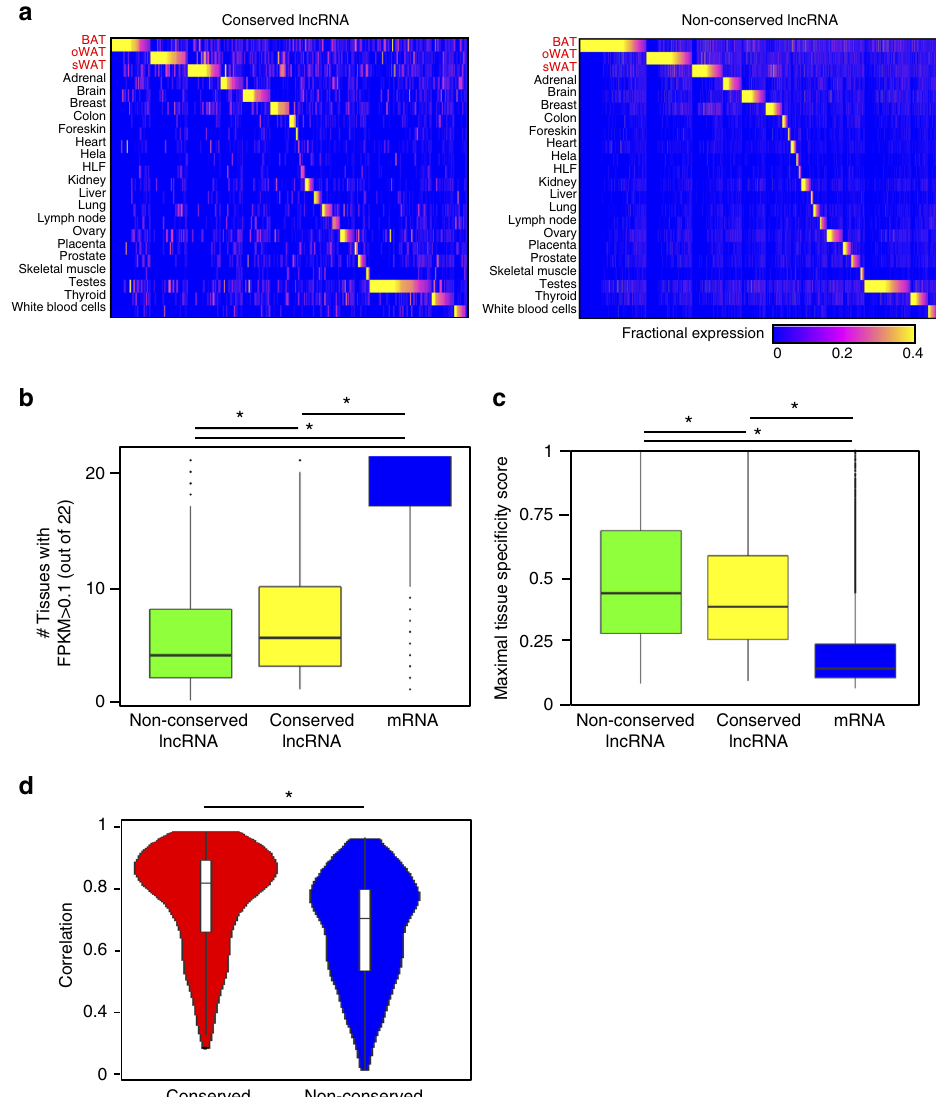
Fig. 5 Conserved lncRNAs are more broadly expression in more tissues types. a Tissue speci fi city of 318 conserved (left panel) and 2831 non-conserved (right panel) lncRNAs across 22 examined human tissues. b Boxplots comparing the counts of tissues in which non-conserved lncRNAs, conserved lncRNAs, and mRNAs can be detected (FPKM > 0.1). Tissue counts refer to the number of tissues (out of 22) that show expression level FPKM > 0.1 for each category of transcripts. Non-conserved lncRNAs have the lowest tissue counts, followed by conserved lncRNAs and mRNAs. Non-conserved lncRNAs vs. conserved lncRNAs: p -value = 0.0001587; non-conserved lncRNAs vs. mRNAs: p -value < 2.2e-16; conserved lncRNAs vs. mRNAs: p -value < 2.2e-16. Mann – Whitney U -test. c Boxplots comparing maximal tissue speci fi city scores among non-conserved lncRNAs, conserved lncRNAs, and mRNAs. Maximal tissue speci fi city score is de fi ned by the maximal fractional expression of the examined lncRNAs among all 22 tissues. Non-conserved lncRNAs show the highest tissue speci fi city, followed by conserved lncRNAs and mRNAs. Non-conserved vs. conserved, p -value = 0.003371; non-conserved vs. mRNA, p -value < 2.2e-16; conserved vs. mRNA, p -value < 2.2e-16. Mann – Whitney U -test. d Violin plots representing the distribution of all possible pairwise correlations among 22 tissues, using either conserved or non-conserved lncRNAs. Correlations between tissues generated using conserved lncRNAs are signi fi cantly higher than using non-conserved lncRNAs. Mann – Whitney U -test, p -value = 3.362e-11. * denotes signi fi cant p-value <